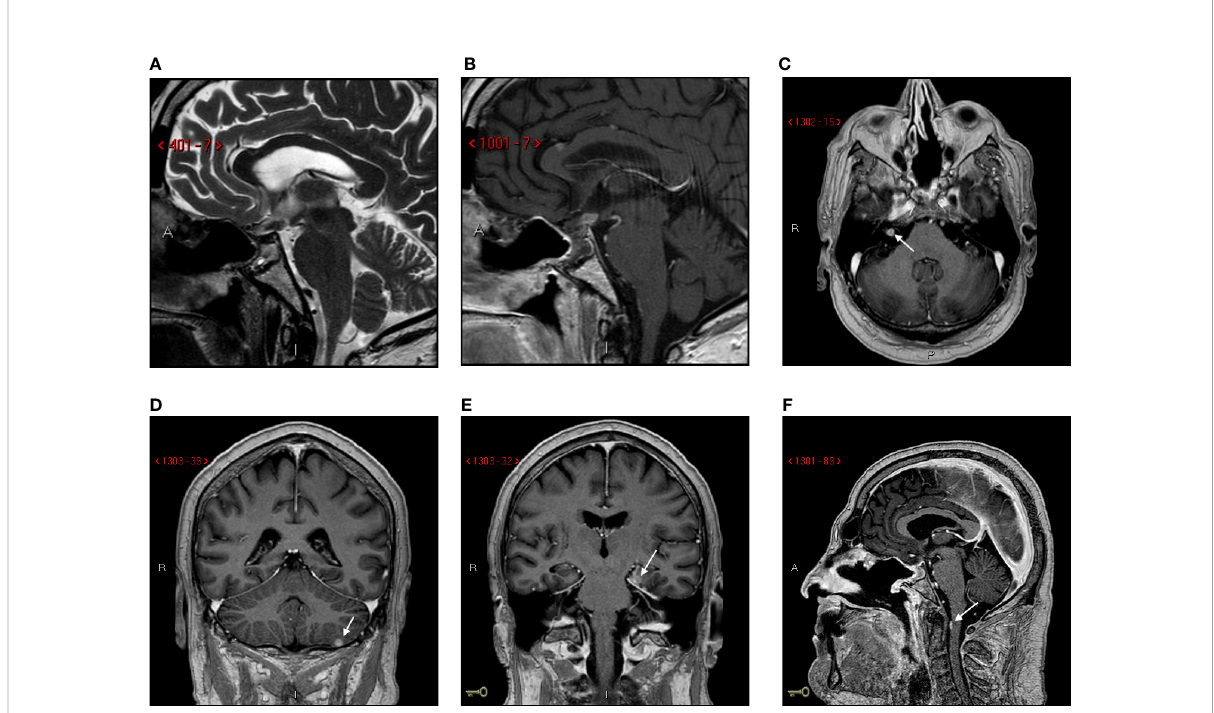
FIGURE 4 Follow-up MRI scan at 139 days. Sagittal T2-Weighted (A) and post-contrast T1-weighted (B) images. Post-surgical sellar modi fi cation with small residual tumor in suprasellar/infundibular region. Axial post-contrast T1-weighted images (C-F) : multifocal leptomeningeal dissemination